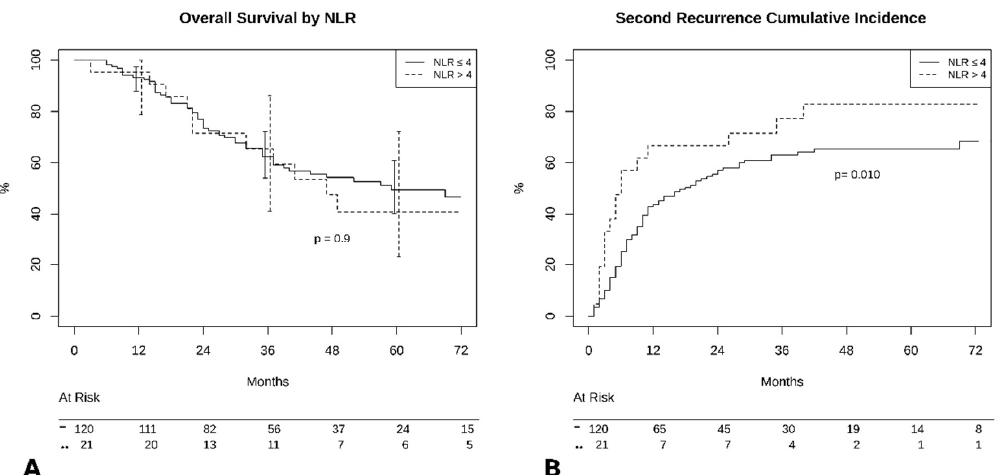
Figure 1. ( A ) Overall survival by neutrophil-to-lymphocyte (NLR) groups. ( B ) Cumulative incidence of recurrence by NLR groups.